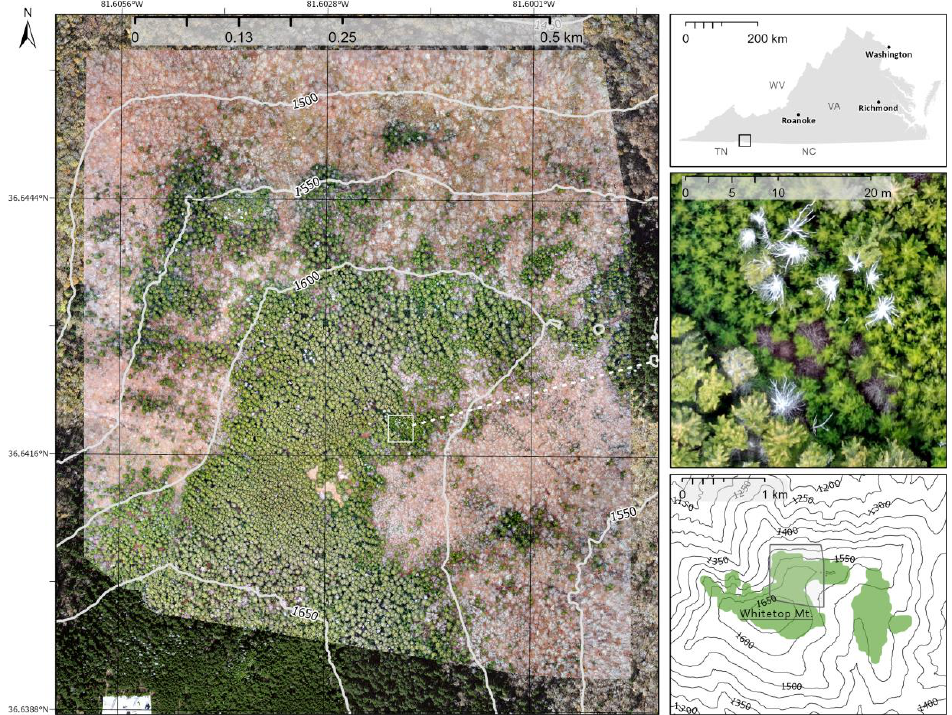
Figure 2. Orthoimagery (3.6 cm 2 resolution) of the 46-hectare sample plot within the red spruce forest at Whitetop Mountain is shown on the left . The inset maps/image on the right show ( top ) the Whitetop Mountain area within the Commonwealth of Virginia, ( center ) a close-up of dead spruce and surrounding sapling release orthoimagery shown on the left, and ( bottom ) the sample plot (grey line) outlined over a contour map and delineation of the spruce